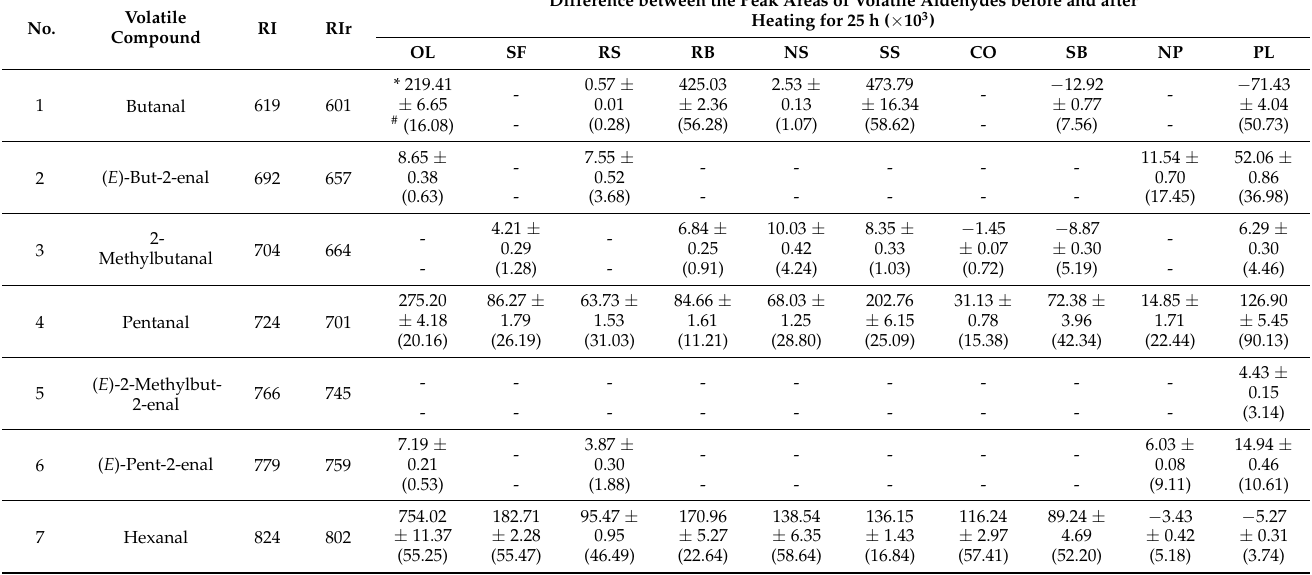
Table 2. Difference between the peak areas of 21 volatile aldehydes detected in 10 edible oils before and after heating for 25